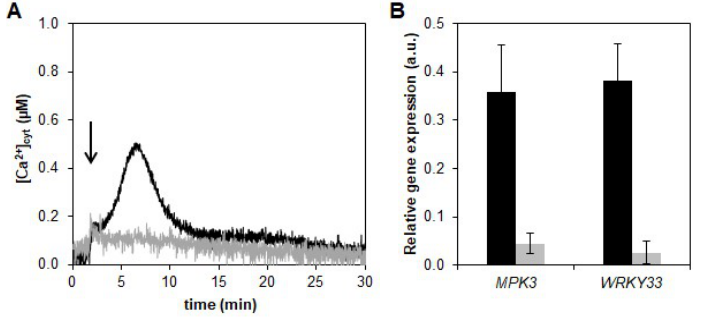
Figure 5. Effect of pretreatment with EGTA and Ned-19 on HYTLO1-induced [Ca 2+ ] cyt transient and gene expression in L. japonicus cells. ( A ) Monitoring of [Ca 2+ ] cyt in L. japonicus after treatment (arrow) with 0.6 µ M HYTLO1 in regular cell culture medium (black trace) or after pretreatment with 600 µ M EGTA and 100 µ M Ned-19 in Ca 2+ -free medium (grey trace). ( B ) RT-PCR analysis of the expression of MPK3 and WRKY33 after treatment with HYTLO1 (0.6 µ M) for 2 h in regular medium (black bar) or in